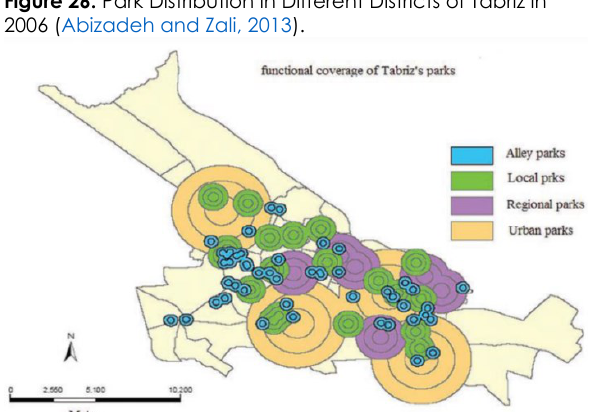
Figure 27. Function Level of Urban Parks in Tabriz (Abizadeh and Zali,